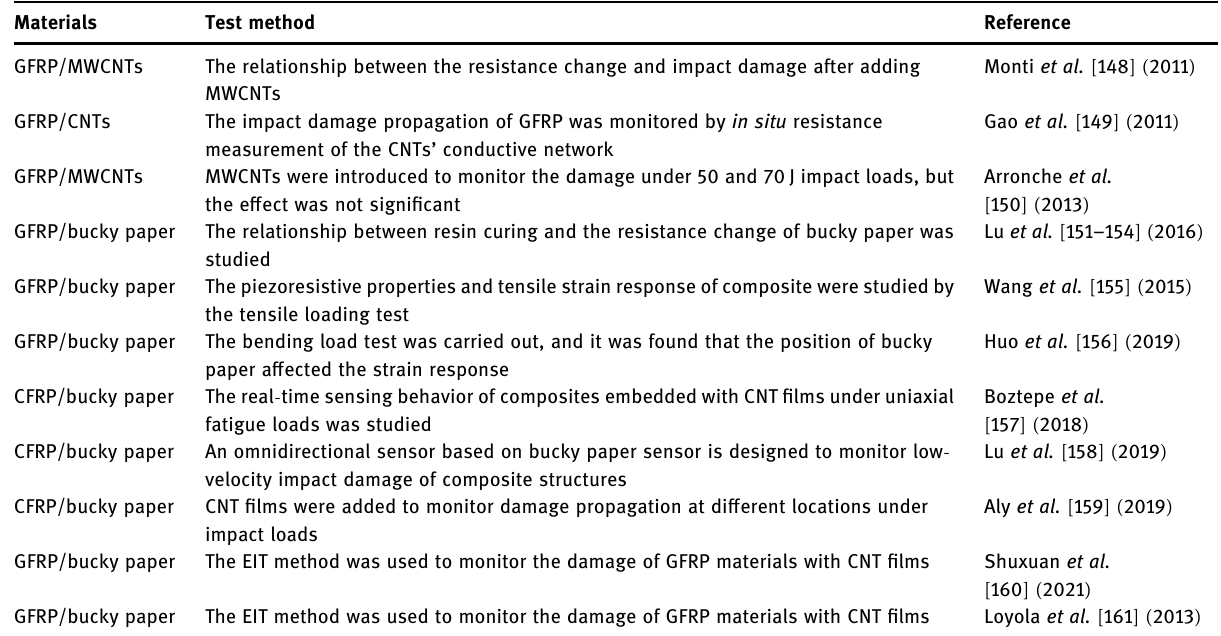
Table 4: Researches on the SHM of multiscale composites of the CNT - reinforced FRP Materials